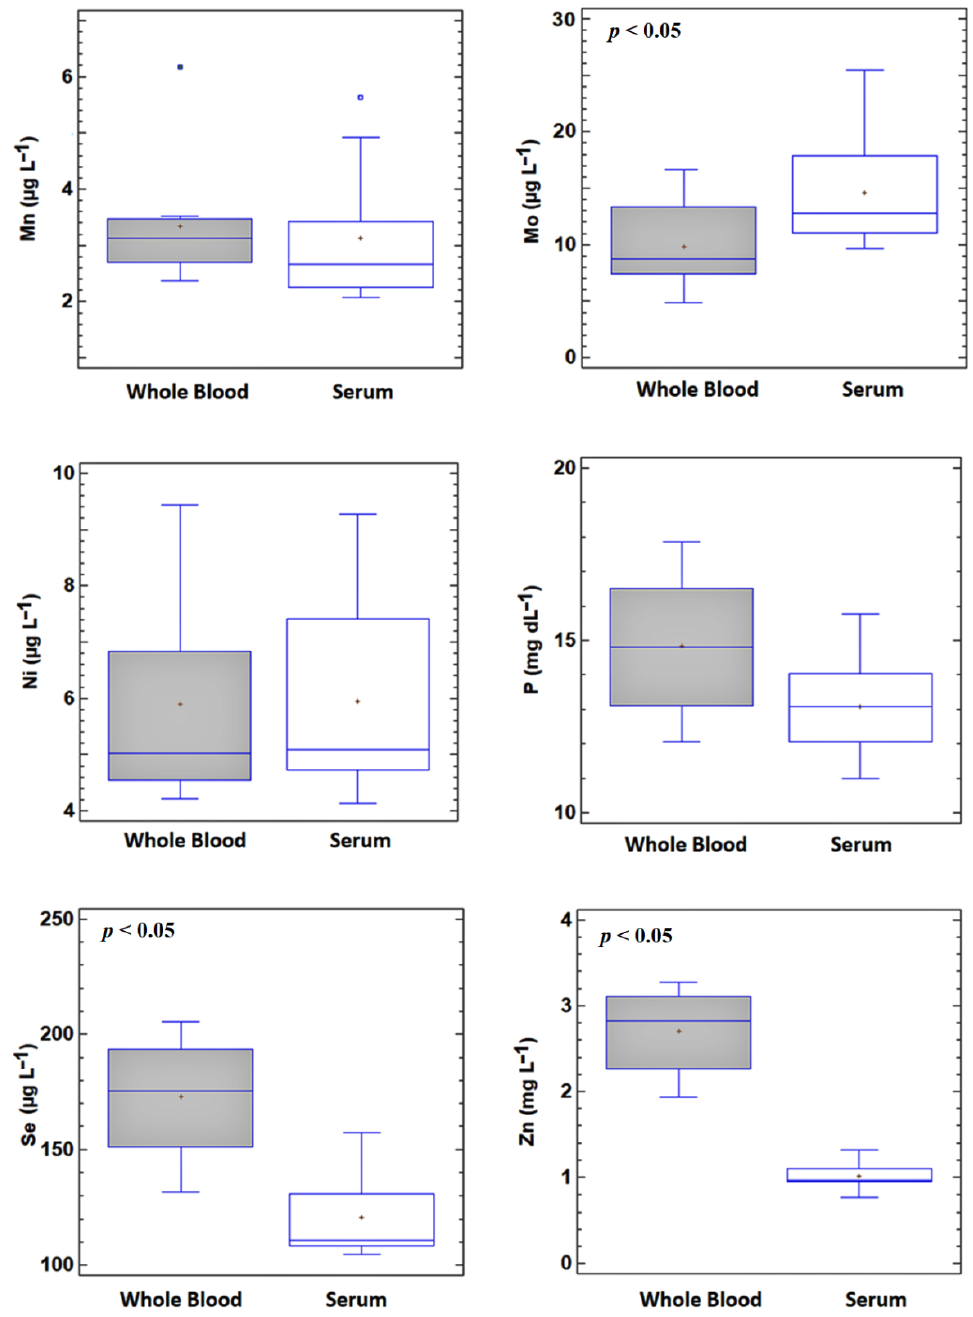
Figure 1. Box-and-whisker plots showing macro and microminerals in paired whole blood and serum samples ( n = 10). p < 0.05 indicates a statistically significant difference between whole blood and serum values. Cr, Fe, Se and Zn are significantly higher in whole blood and Ca, Mg and Mo are significantly higher in serum.